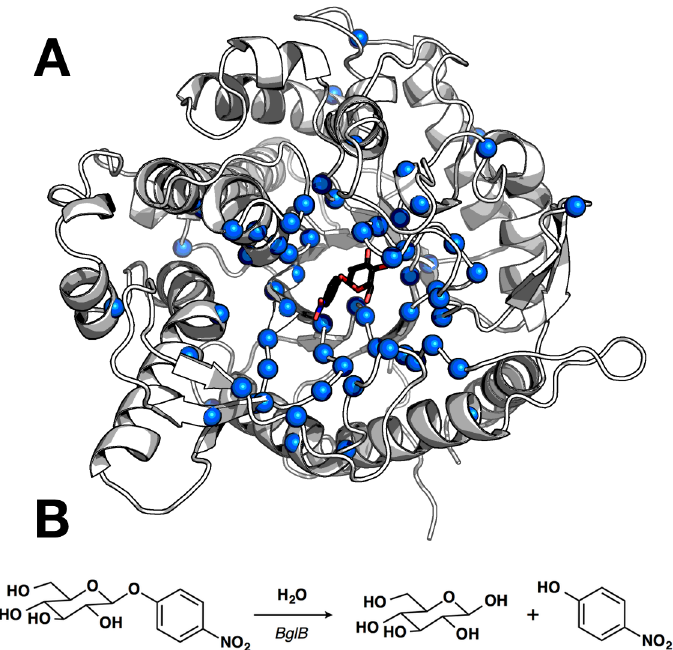
Fig 1. Structure and catalyzed reaction of BglB. (A) Structure of BglB in complex with the modeled p - nitrophenyl- β -D-glucoside (pNPG) used for design. Alpha carbons of residues mutated shown as blue spheres. The image was drawn with PyMOL. [16] (B) The BglB – catalyzed reaction on pNPG used to evaluate kinetic constants of designed mutants.